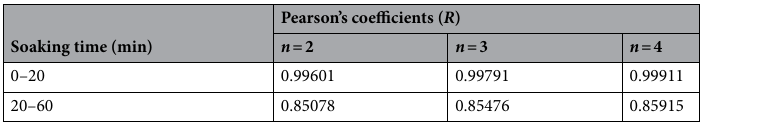
Table 1. Variation of Pearson’s coefficients of the Al–Fe–Cu alloy heated at 630 °C with power exponents.